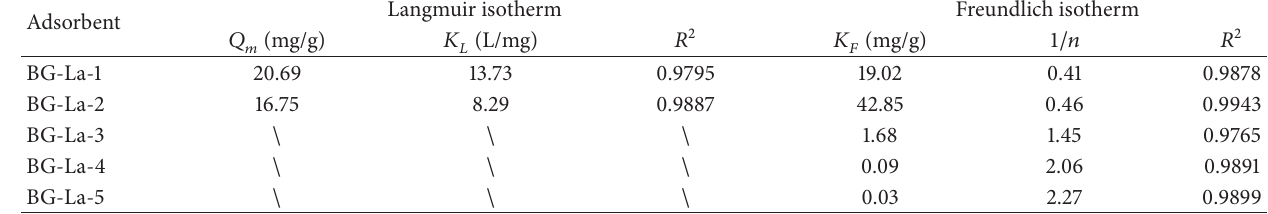
Table 4: Parameters calculated from isotherm equations for MB onto BG-La.